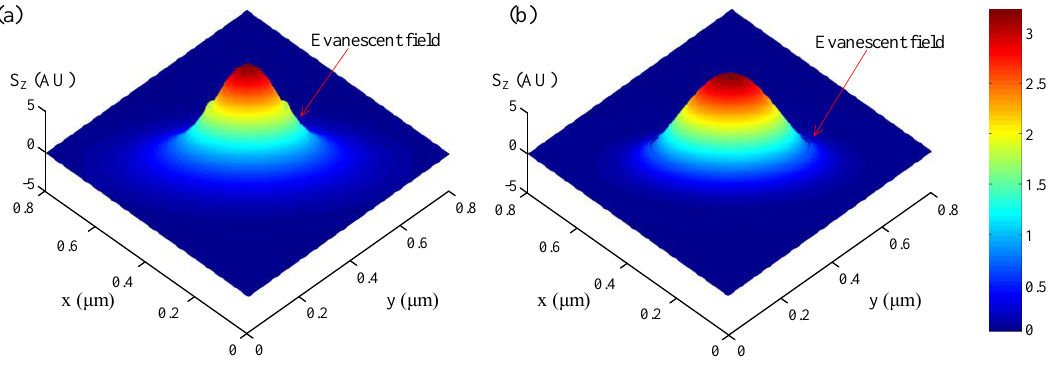
Figure 2. Z -Components of the Poynting vectors ( S 400 nm diameter silica microfibers at 325 nm wavelength [12].